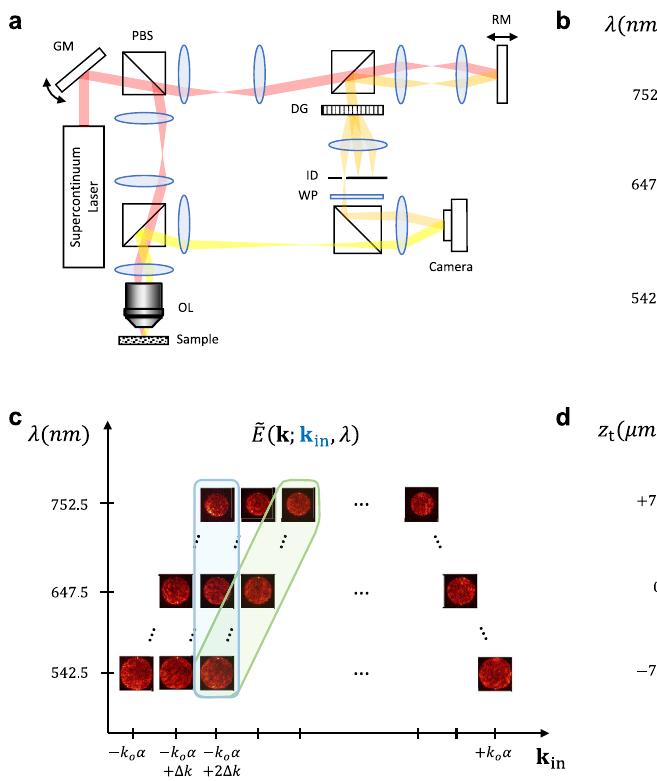
Fig. 2 | Spectro-angular representation of volumetric image reconstruction (cid:1) (cid:3) framework. a Experimental setup. Re fl ected wave E r; θ in , λ was measured by scanning both incident angle θ in and wavelength λ via off-axis holographic phase microscopy. GM: a galvanometer scanning mirror, PBS: a polarizing beam splitter, OL:theobjectivelens,RM:thereferencemirror,DG:thediffractiongrating,ID:the (cid:1) (cid:3) iris diaphragm, WP: A wave plate. b A measured set of E r; θ in , λ displayed with respect to λ and θ in . Each image has view fi eld of 22×22 μ m 2 . c Spatial